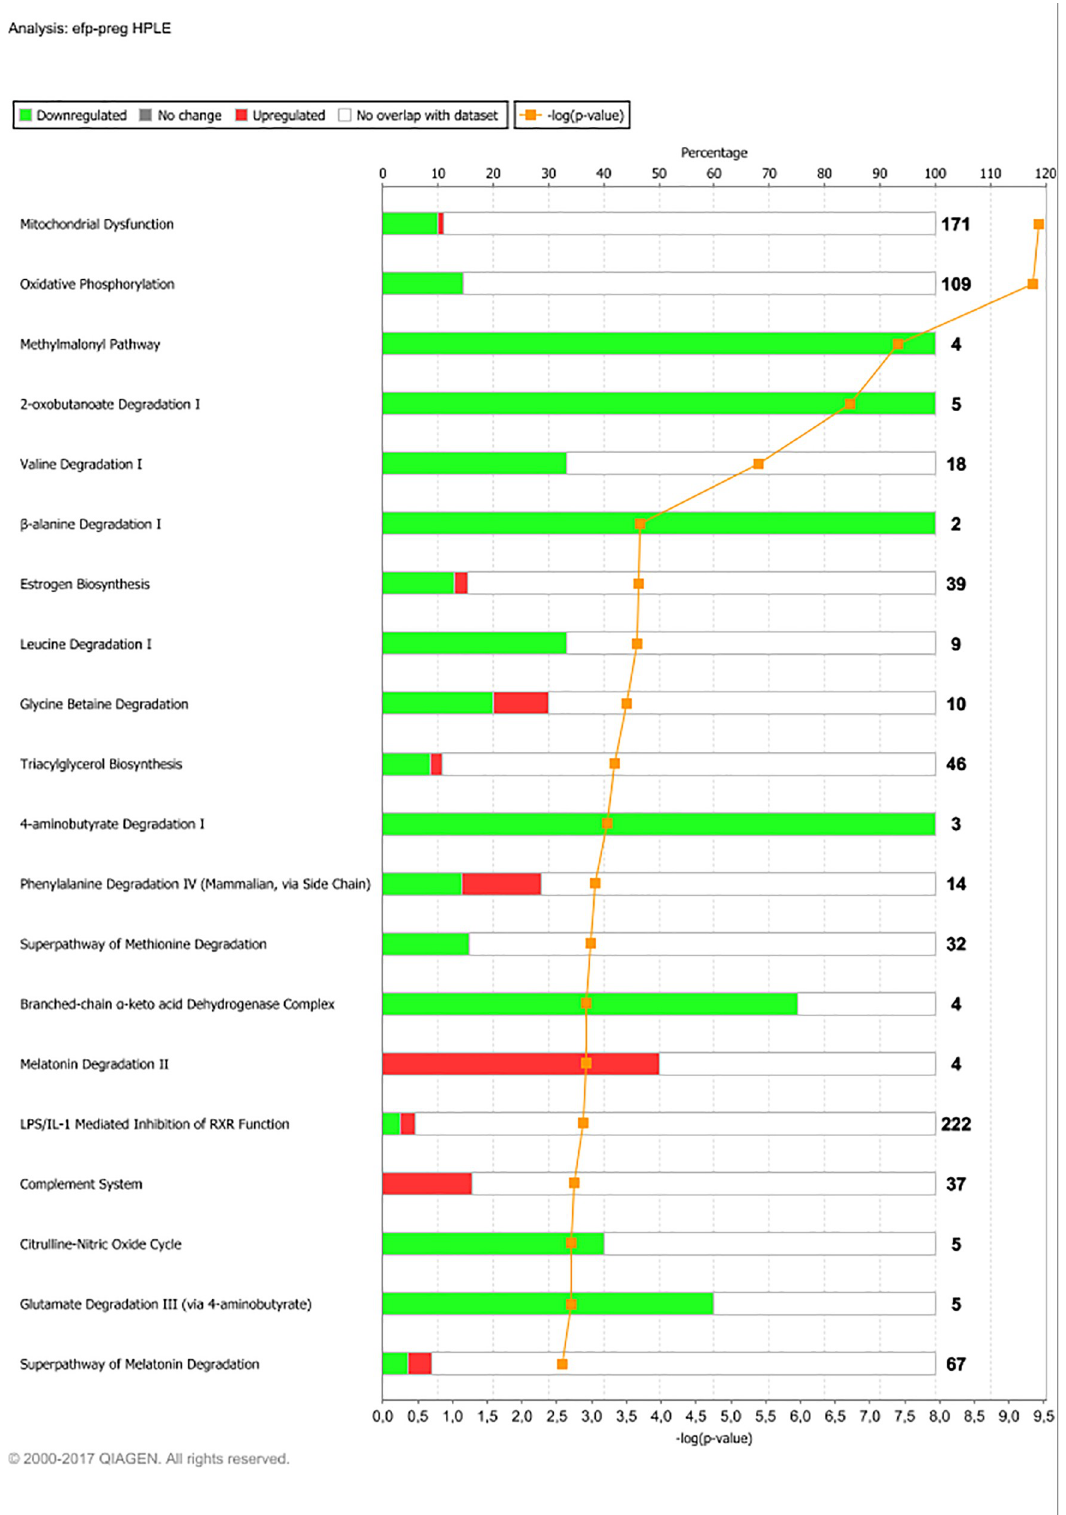
Fig 7. Main affected pathways from experimental feeding period (12MO) to pregnancy (PREG) for High-protein, Low-energy fed heifers (HPLE). Main affected pathways for HPLE heifers during development from experimental feeding at 12 months of age,